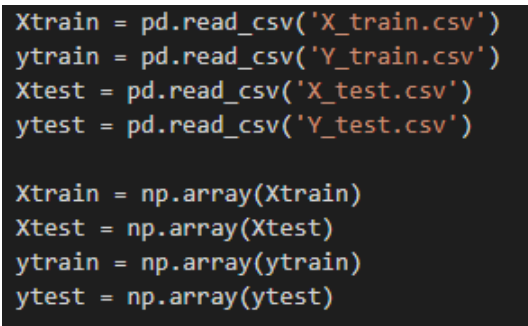
Figure 5. Dividing the dataset into Training and Test datasets.